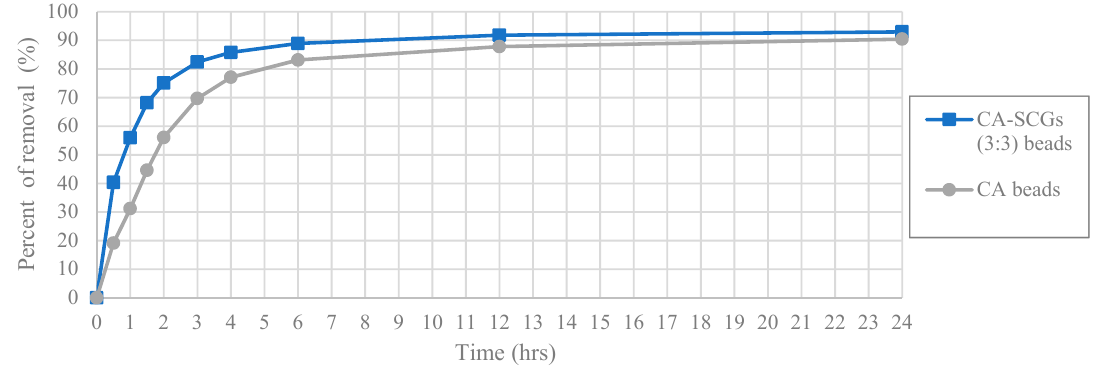
Figure 12. Plot of Percent of removal vs Time at initial concentration of 60 ppm of Cu 2+ , CA and CA- SCGs (3:3) beads.